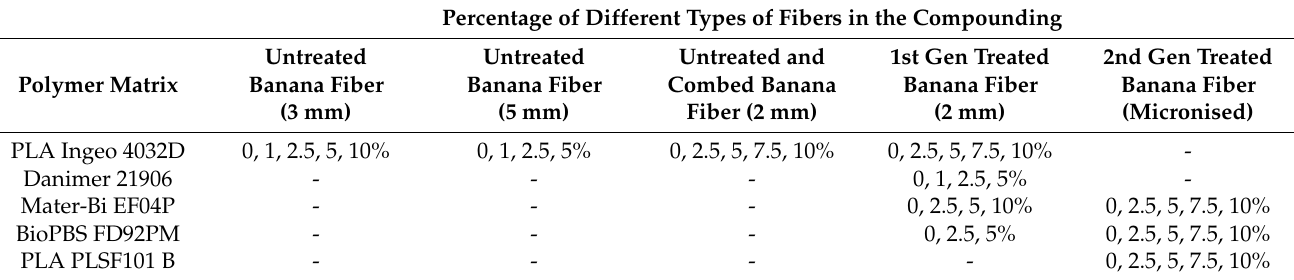
Table 4. Compounding formulations for characterization (mold injected samples). Percentage of Different Types of Fibers in the Compounding